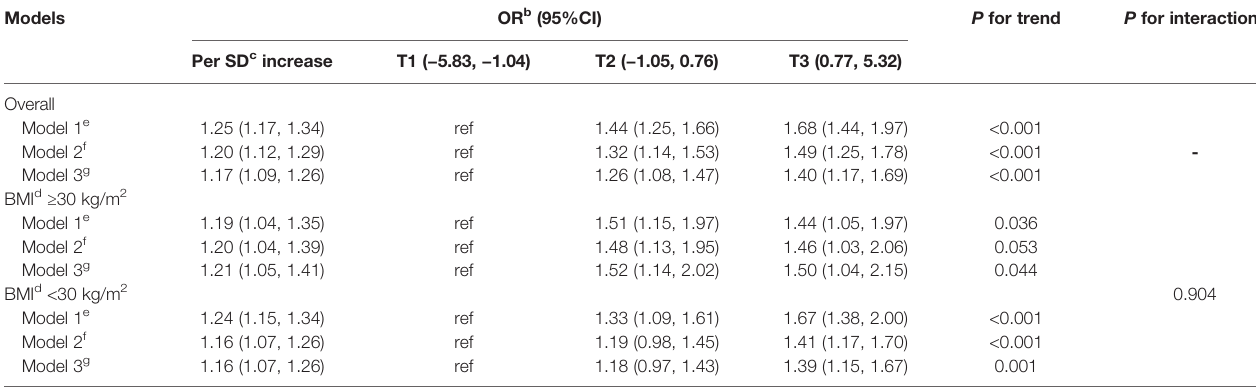
TABLE 2 | b -Coef fi cients (95%CIs) a for the relationship between the dietary in fl ammatory index and the markers of T2D risk (National Health and Nutrition Examination Survey 2007 – 2016). Outcomes